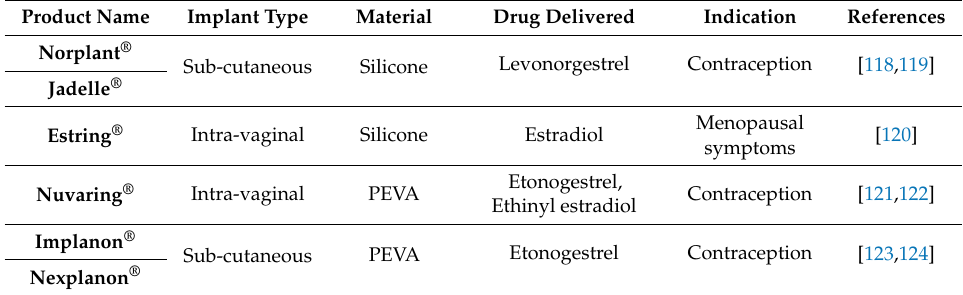
Table 1. Examples of implantable drug delivery devices used in the area of women’s health.